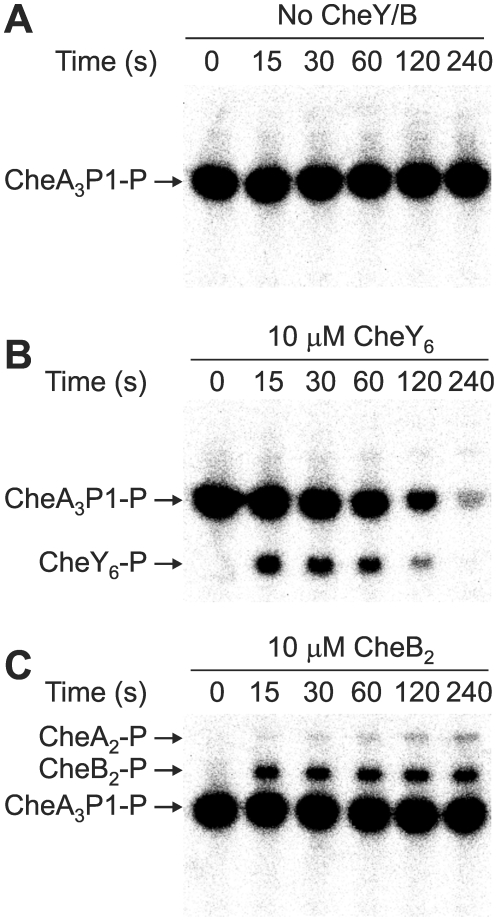
Phosphorimages of SDS-PAGE gels measuring phosphotransfer rate from CheY6-P and CheB2-P to CheA2.30 µM CheA3P1-32P was incubated with 5 µM CheA2 for 1 hour prior to the addition of (A) reaction buffer, (B) 10 µM CheY6 and (C) 10 µM CheB2. 10 µl reaction samples were then taken at the time points indicated and quenched in 20 µl of 1.5 X SDS/EDTA loading dye. The quenched samples were analyzed by SDS-PAGE and detected by phosphorimaging.